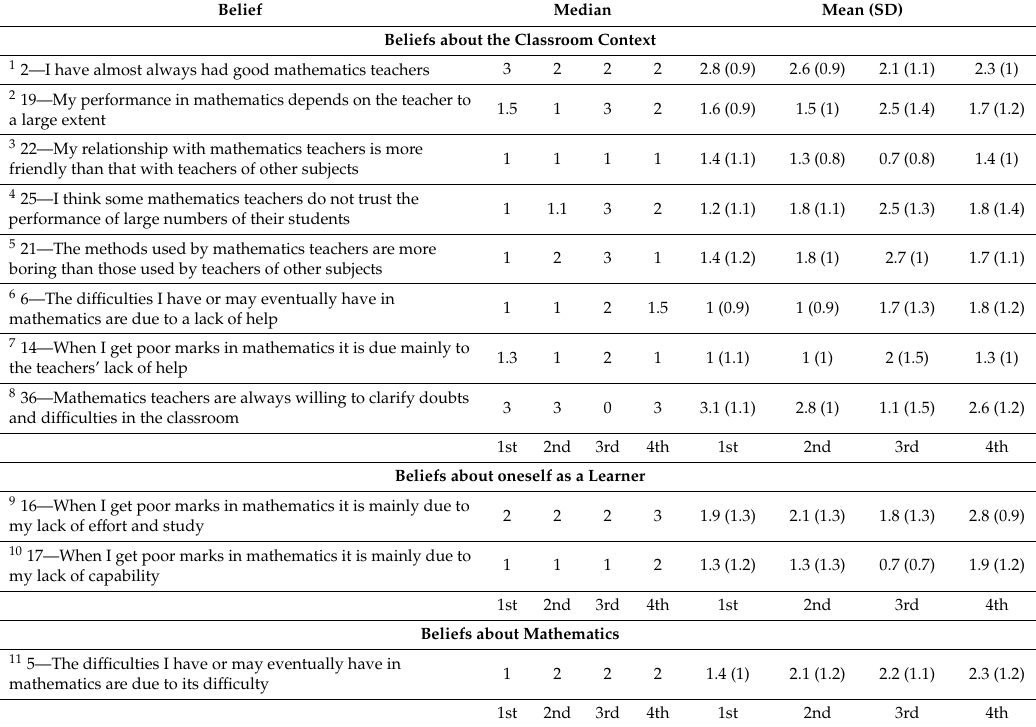
Table 6. Beliefs about mathematics with significant di ff erences according to academic level, grouped into the three categories